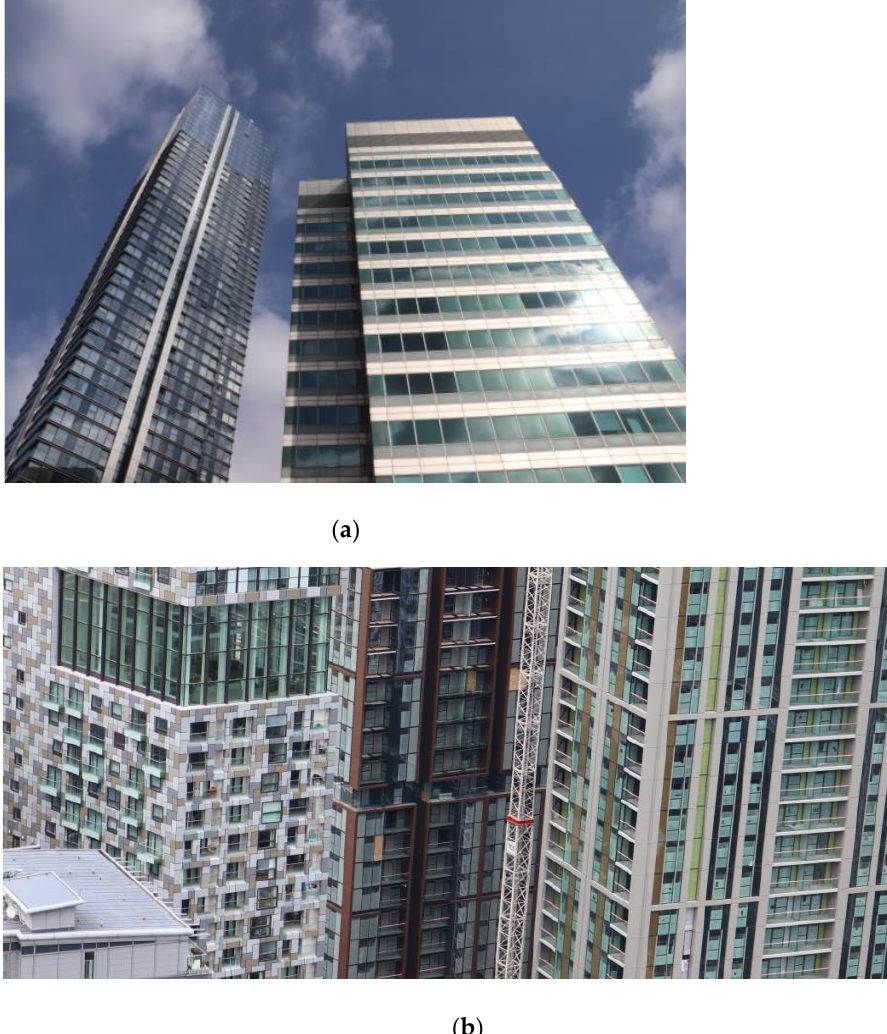
Figure 19. Optical illusions as means of architectural expression. ( a ) South Quay Plaza: The residential tower and office building where contrasting tint highlights vertical and horizontal detailing, respectively (2021); ( b ) Facades of Franklin Tower, Maine Tower and Sirocco Tower with colour detail applied to break down the mass into smaller sections (2020).